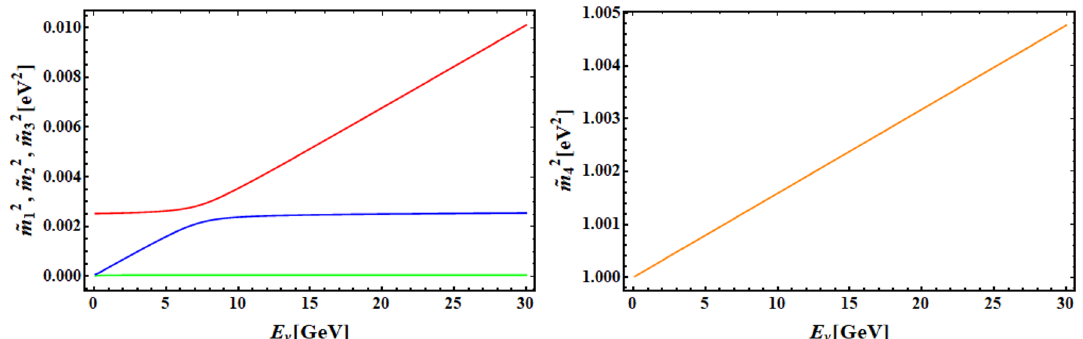
in green, ~ m 2 in 1 2